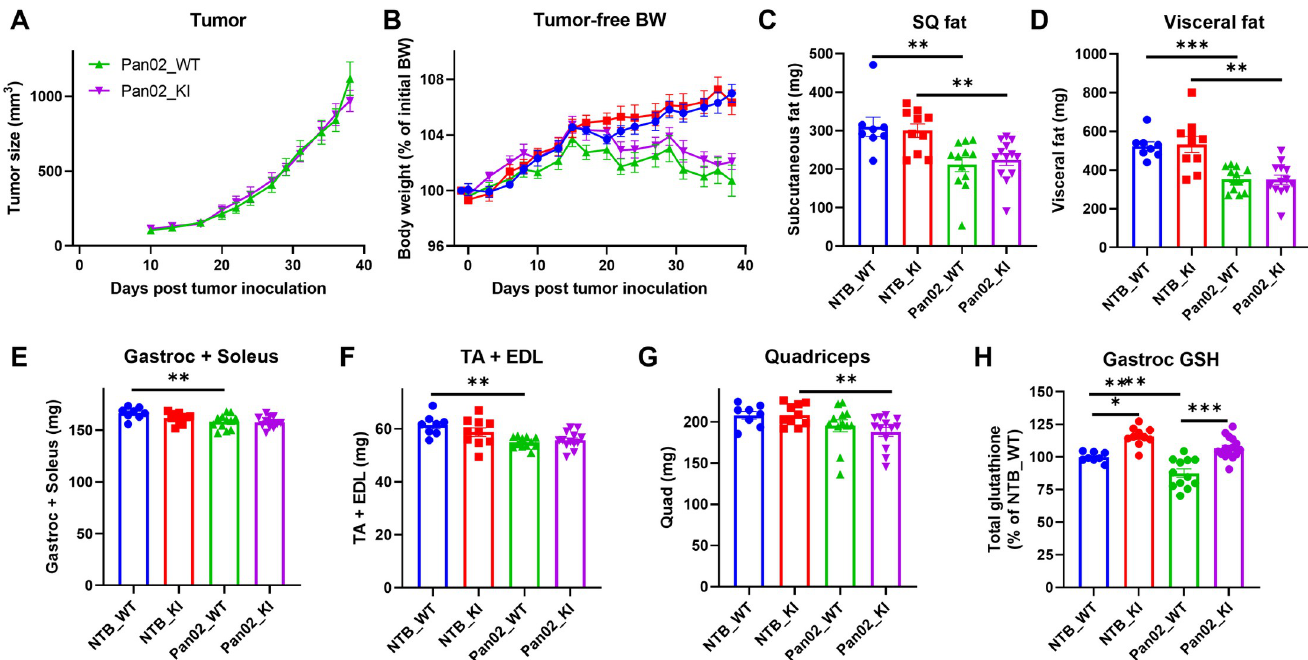
Fig 4. Chac1 inactivation preserves muscle glutathione but does not protect against muscle wasting in the Pan02 cachexia model. A. Tumor growth curves in Pan02 tumor-bearing WT and KI mice. B. Curves of estimated tumor-free body weights normalized by initial body weights on day 0. Weights of C. Subcutaneous (SQ) adipose tissue, D. Visceral adipose tissue, E. Gastrocnemius and soleus muscle, F. tibialis anterior (TA), and extensor digitorum longus (EDL) muscle, and G. Quadriceps muscle measured at takedown. H. Total glutathione measured in gastrocnemius muscles. Results are shown as mean ± SEM with individual data plotted. Statistical significances were indicated as: * P < 0.05, ** P < 0.01, *** P < 0.001.